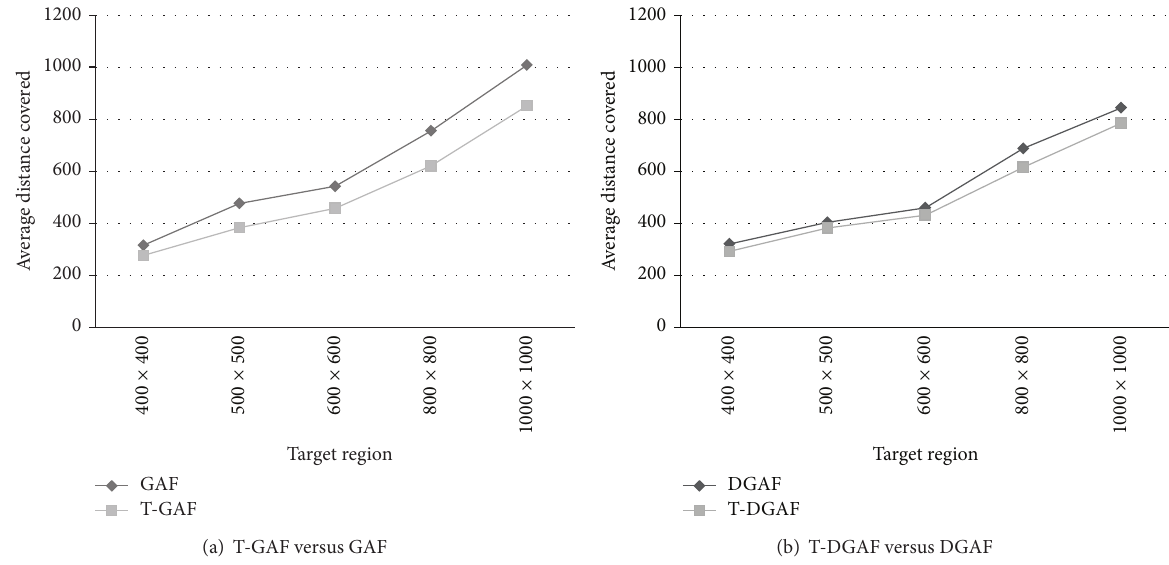
Figure 8: Comparison of the average distance covered by the data packets for different size of target regions.